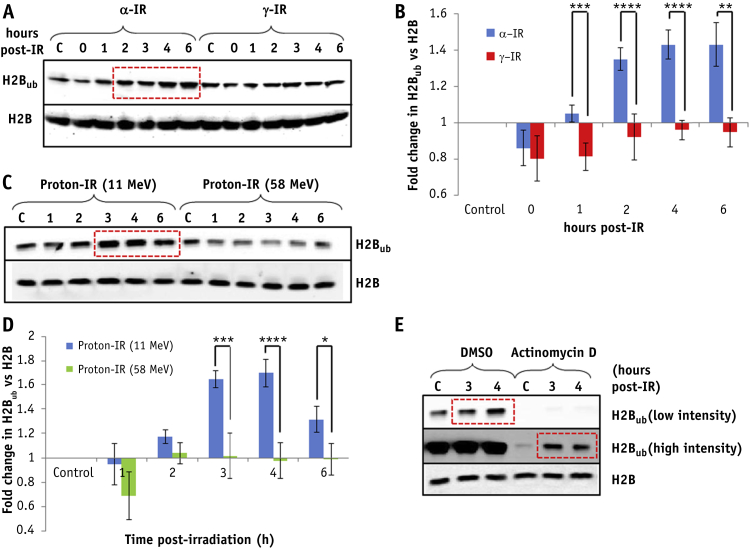
H2Bub is induced in HeLa cells in response to complex DNA damage induced by high linear energy transfer (LET) α-particles and protons. (A-D) HeLa cells were untreated (designated C), irradiated with 10 Gy γ-irradiation, α-particles, or protons at low or high LET, and harvested at the time points indicated after ionizing radiation and purified histones analyzed by immunoblotting. In (E), cells were pretreated with dimethyl sulfoxide (DMSO) or actinomycin D before irradiation with 10 Gy high-LET protons. Red boxes indicate increased levels of H2Bub. (B, D) Shown is the mean fold change ± standard deviation in H2Bub normalized against H2B. *P < .05, **P < .01, ***P < .005, ****P < .002, as analyzed by a two-sample t test.